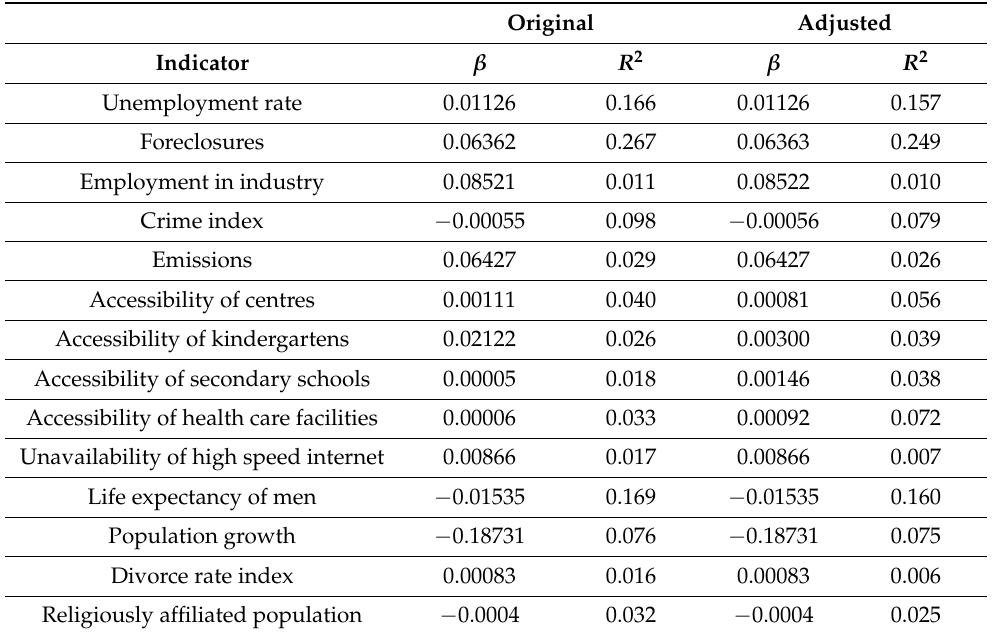
Table 4. Parameters of regression models between indices and input